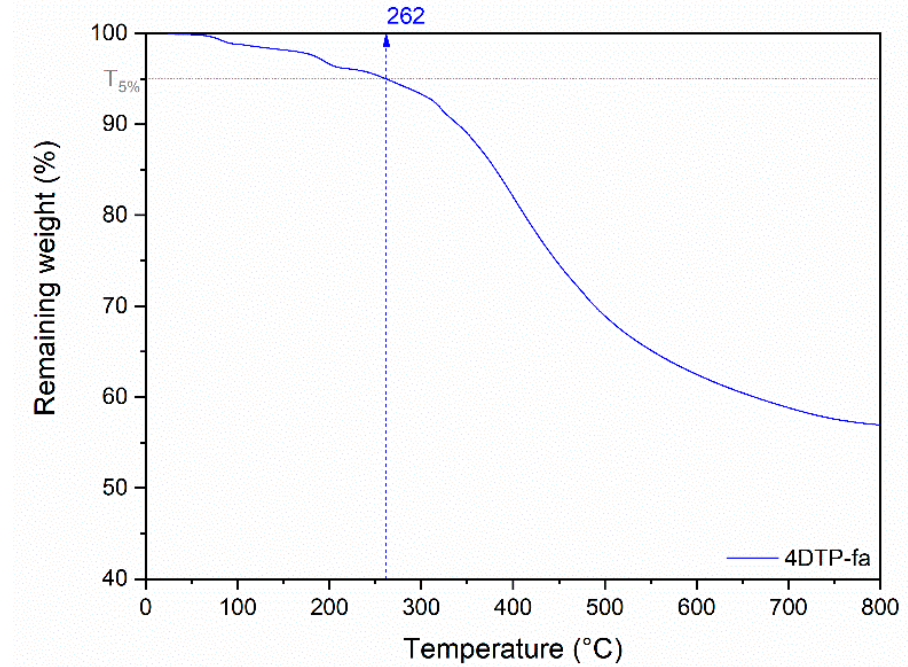
Figure A17. TGA thermogram of 4DTP-fa.